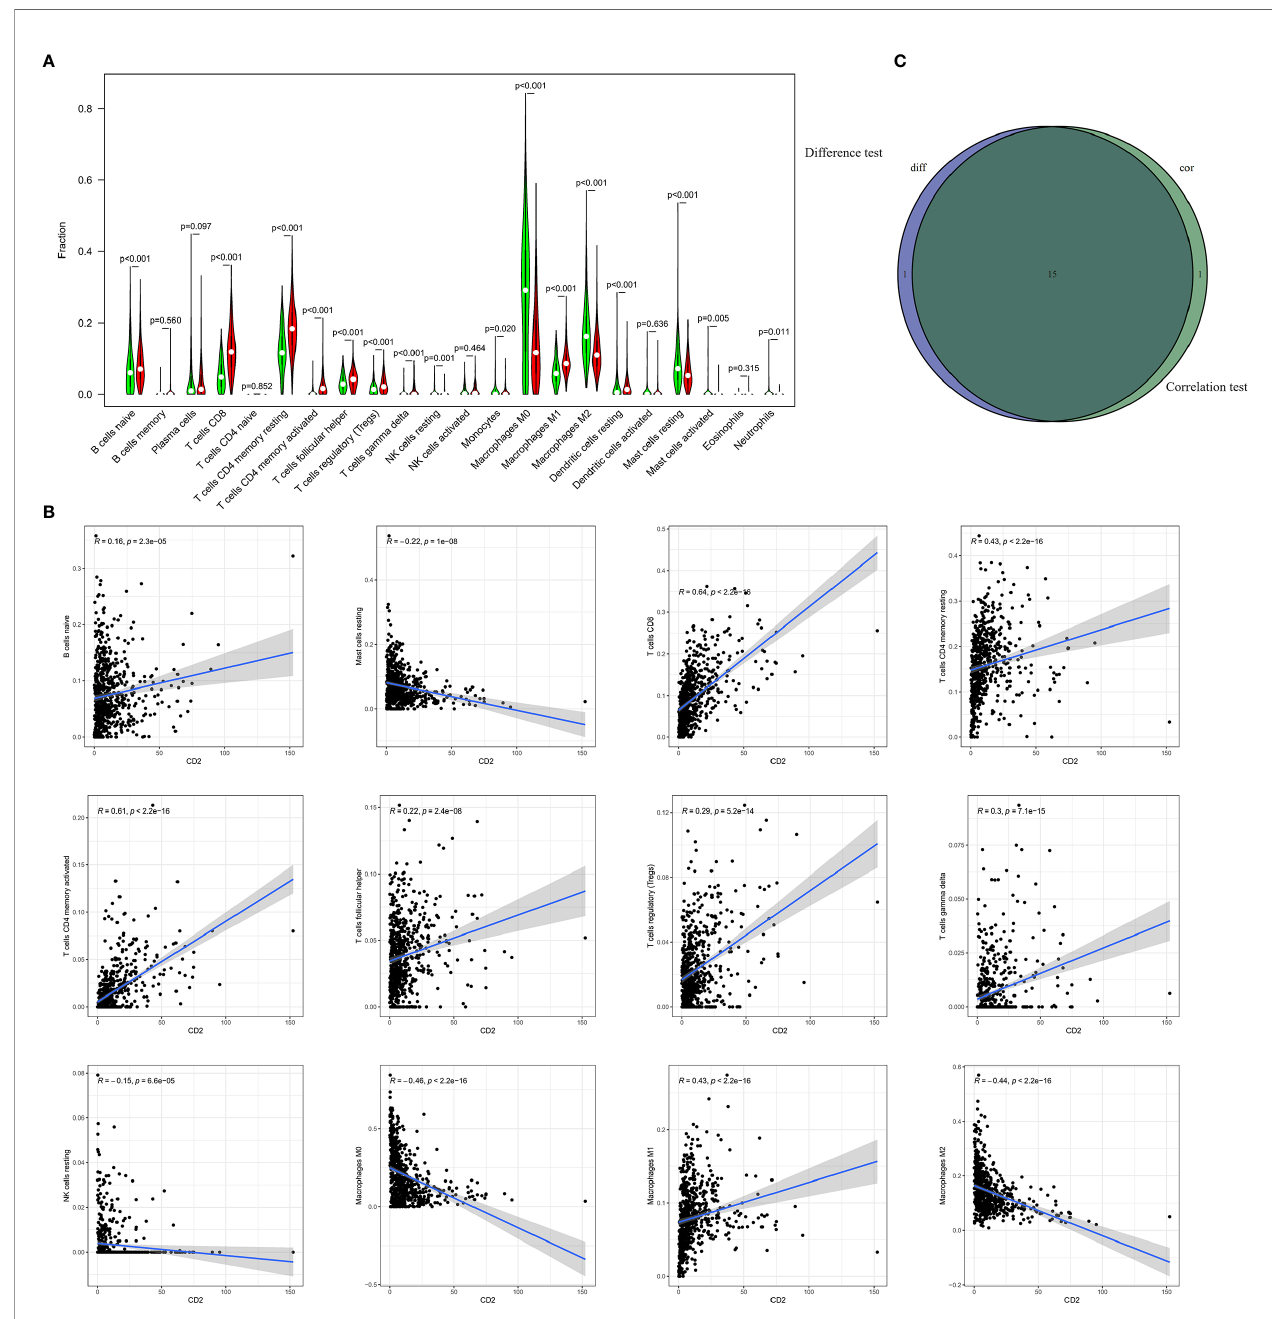
FIGURE 8 | Differences in proportions of TICs between high and low CD2 expression groups and correlations of TICs with CD2 expression. (A) Violin plots of the proportions of 22 immune cell types in tumor tissues with low (green) or high (red) CD2 expression, compared using the Wilcoxon rank sum test. (B) Scatter plots showing Pearson ’ s correlation between the proportions of the 12 most signi fi cant TICs and CD2 expression. Blue lines denote the best- fi t linear models. (C) Venn diagram of intersection between analyses in (A, B) showing that 15 TICs were shared between the